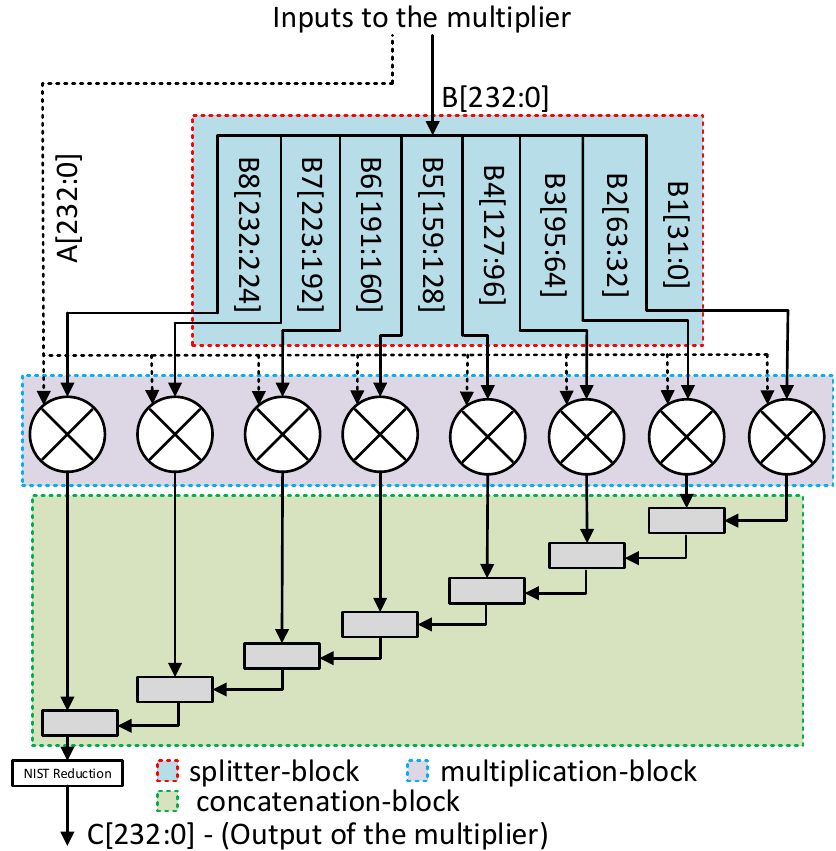
Figure 3. Proposed multiplier architecture for 233- bit polynomial